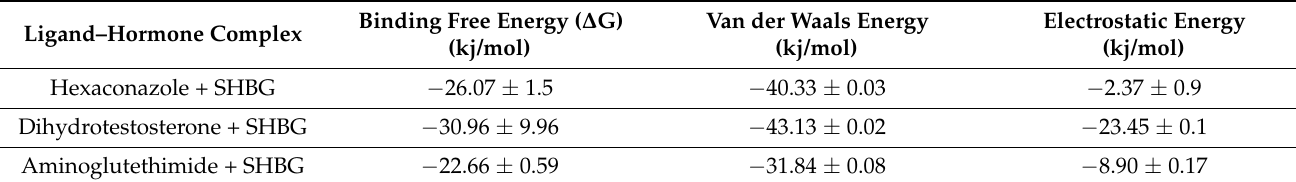
Table 2. MM-PBSA of SHBG.